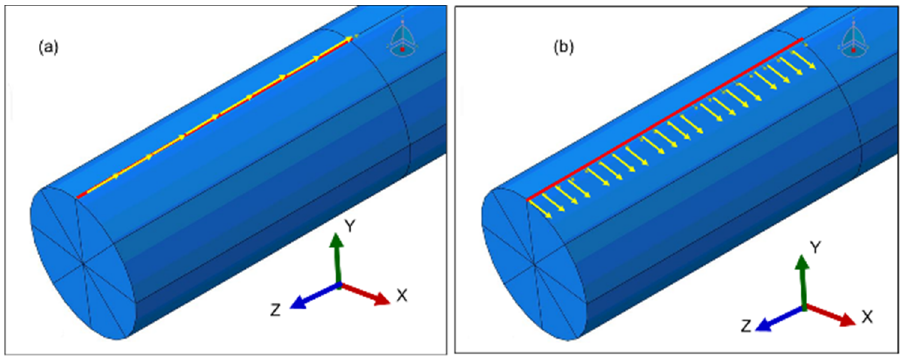
Figure 2. Snapshot of FEM of the cylindrical waveguide and the input loading. ( a ) Parallel and ( b ) perpendicular to the waveguide axis.